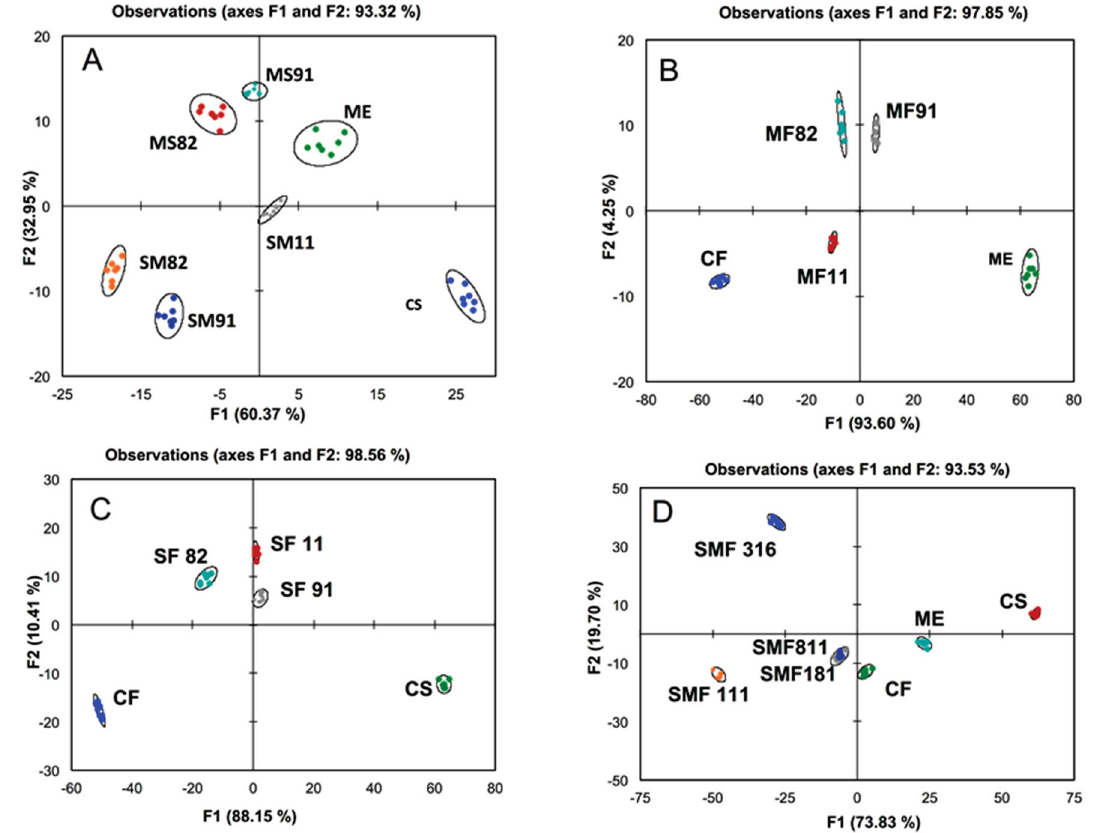
Figure 1. Linear Discriminant Analysis (LDA) score plot of UV-Vis responses of the sensing array to the Cabernet Sauvignon/Merlot blends ( A ), Merlot/Cabernet Franc ( B ), Cabernet Sauvignon/Cabernet Franc ( C ) and tri-blends ( D ). The letters represent the base wines, while the number represent the percentage of each wine. For example, MS28 is a blend of 20% Merlot and 80% Cabernet